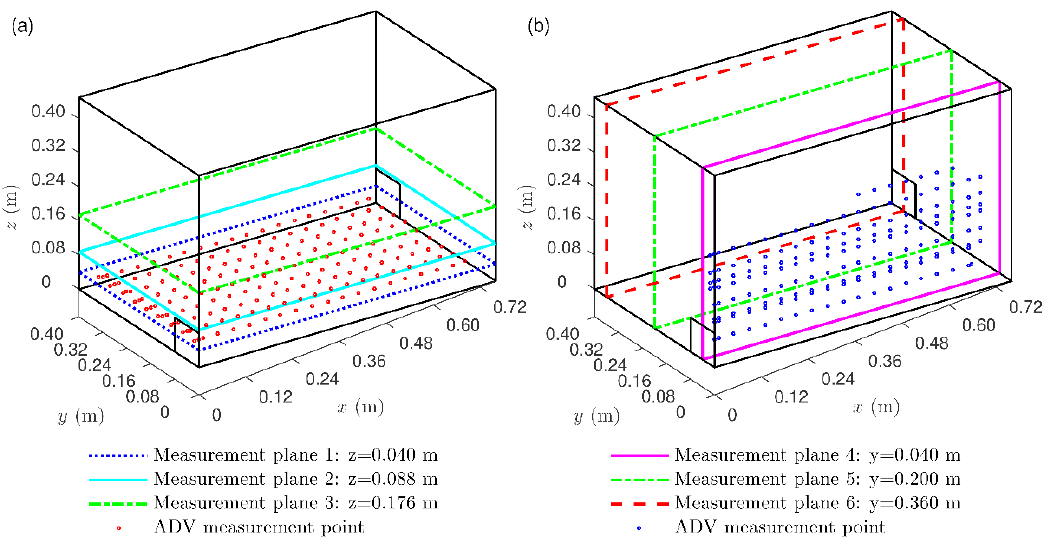
Figure 2. Three dimensional representations of a pool showing the measurement planes and the acoustic Doppler velocimetry (ADV) measurement grid ( a ) measurement planes parallel to the flume bottom; ( b ) vertical measurement planes (ADV measurement grid is only shown in one plane).